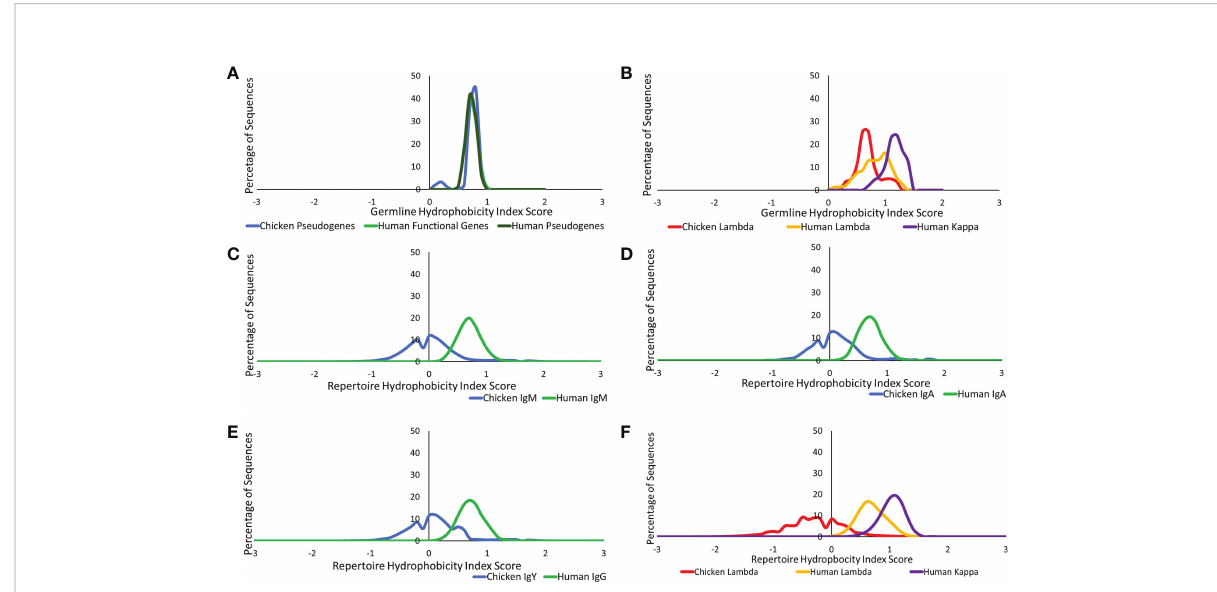
FIGURE 8 Comparison of hydrophobicity of germline variable genes between (A) chicken pseudogenes, human functional genes, and human pseudogenes at the heavy chain loci and (B) chicken pseudogenes, human lambda functional genes, and human kappa functional genes at the light chain loci. Comparison of the hydrophobicity between repertoire sequences shows (C) chicken IgM against human IgM, (D) chicken IgA against human IgA, (E) chicken IgY against human IgG, and (F) chicken lambda light chain sequences against human lambda light chain sequences and human kappa light chain sequences. Hydrophobicity index score calculated by BRepertoire online immunoglobulin repertoire analysis tool using the CDR3 region amino acid sequence.